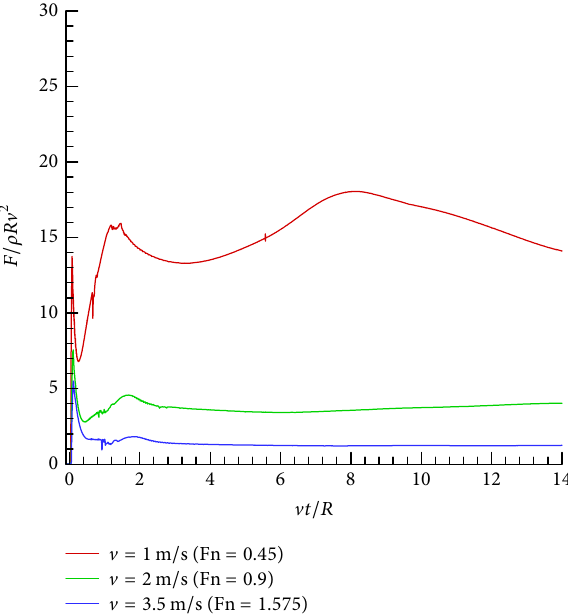
Figure 15: Fluid forces with different vertical